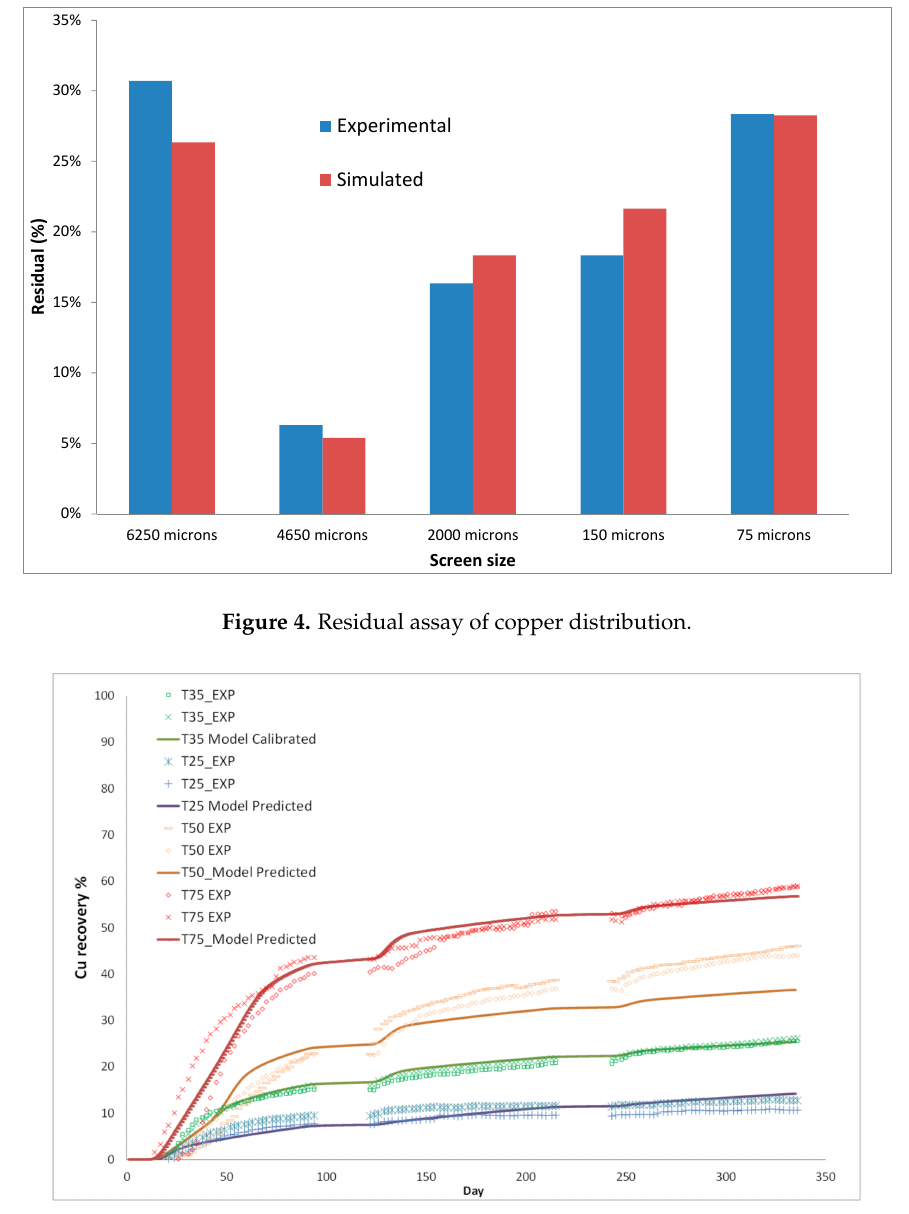
Figure 3. Concentrations in recovered solution.